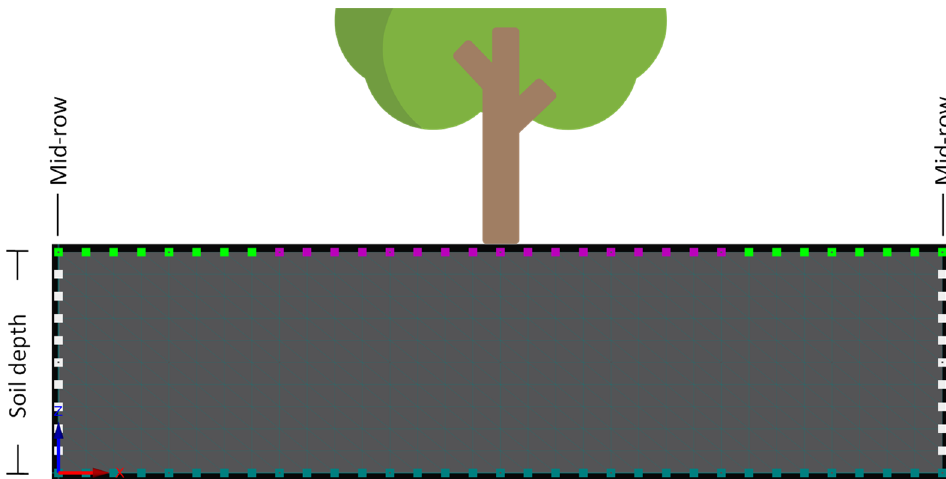
Figure 3. Print screen of HYDRUS-2D representing the model domain geometry, grid mesh (thin blue lines) and boundary conditions. The rectangular cross-section of the African Delight orchard in Robertson has dimensions 4 m (tree row width) × 1 m (soil depth). Boundary conditions at boundary nodes are represented with squares in different colors: light green—atmospheric boundary conditions; purple—surface drip with dynamic wetting; white—no flux boundary; dark green—free drainage boundary.